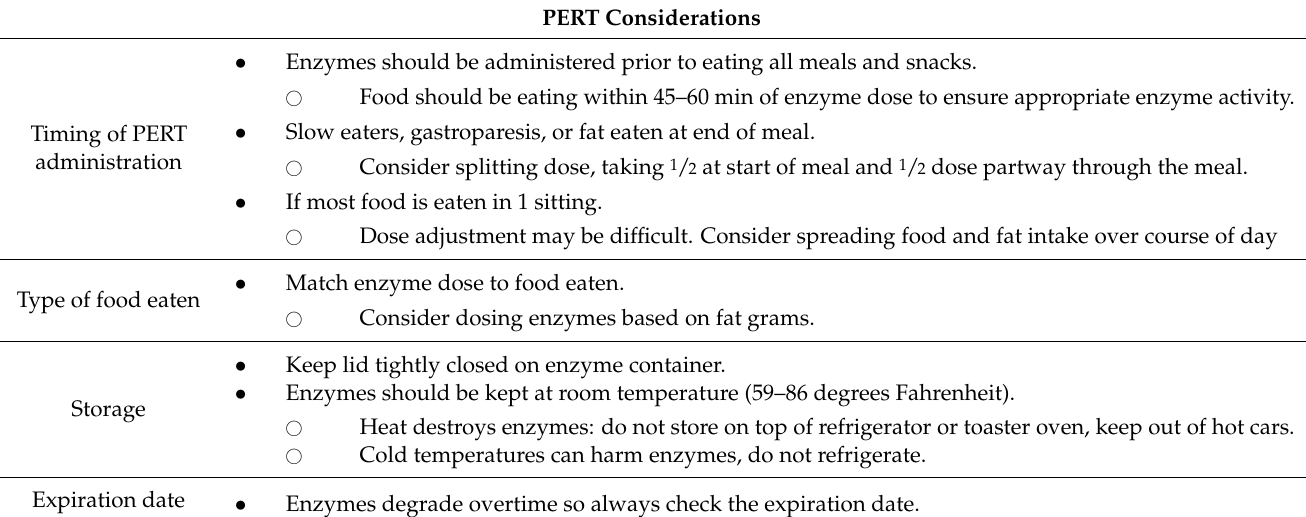
Table 4. Troubleshooting PERT